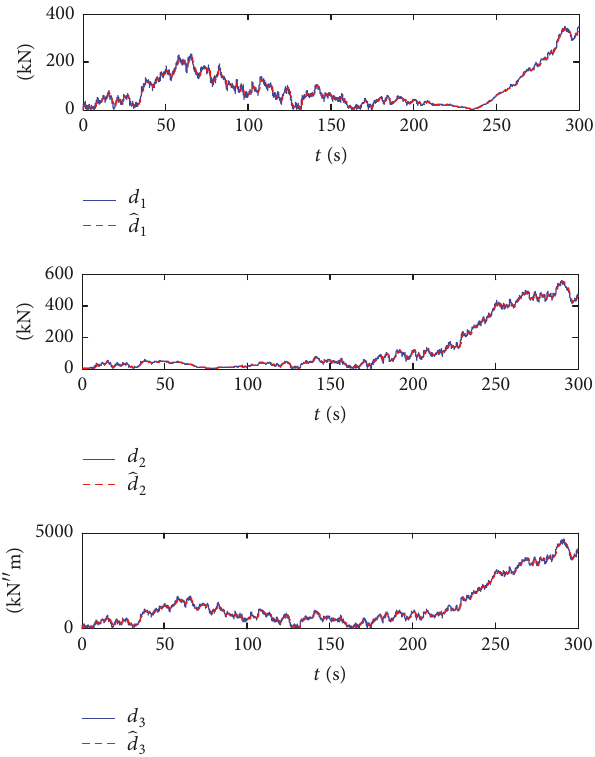
Figure 3: Curves of external environment disturbances d and ̂ d estimations